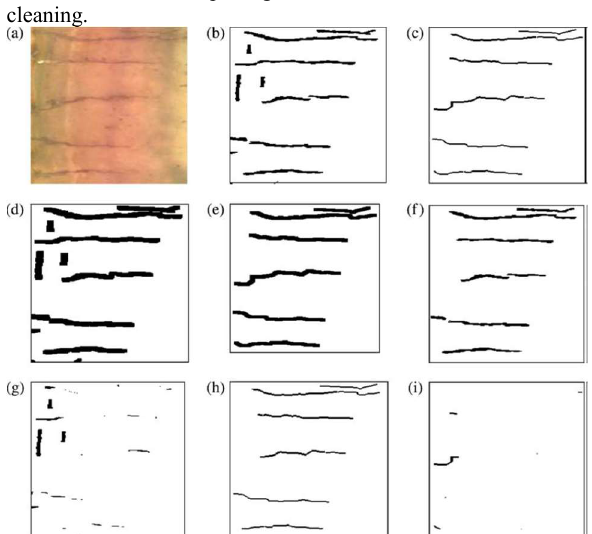
Figure 1: Matching procedure for detection of true and false pixels; (a) original image, (b) detected cracks, (c) ground truth,